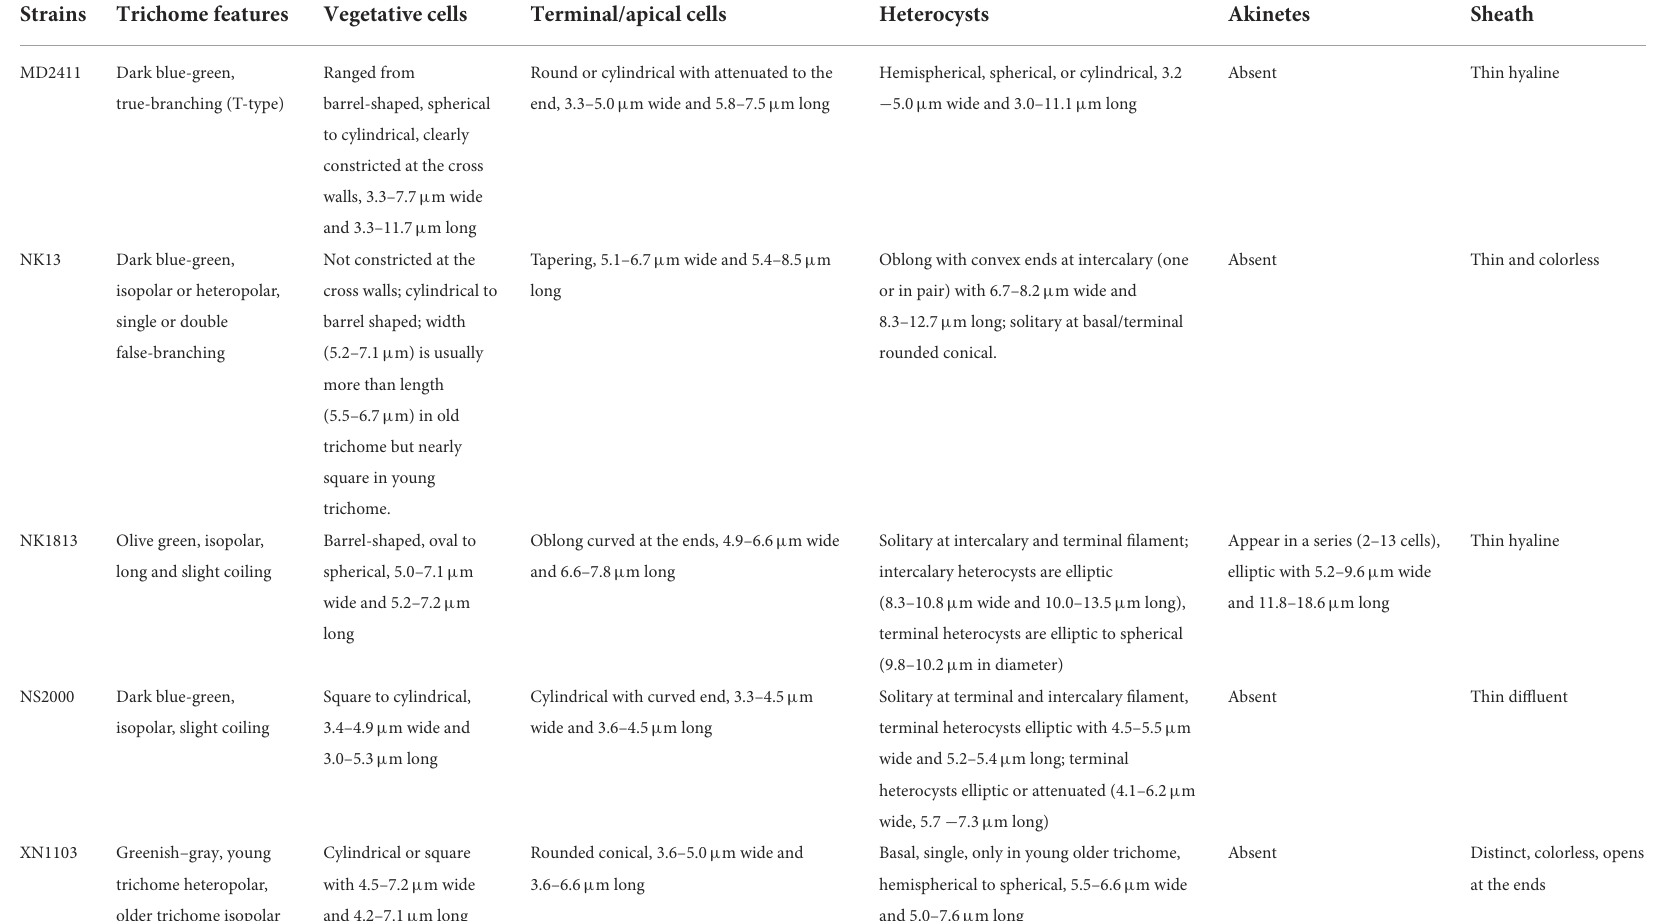
TABLE 1 Morphological and morphometrical characteristics of five isolated cyanobacterial